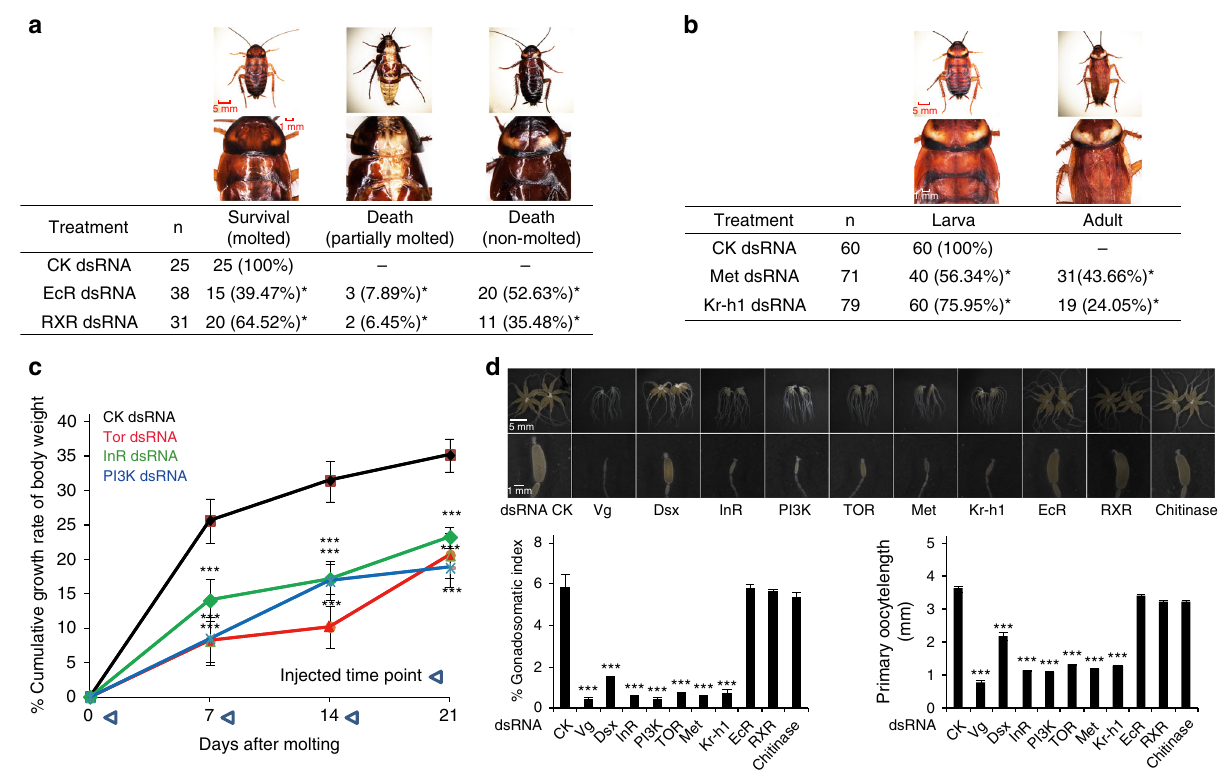
Fig. 4 Functional studies of pathways regulating development and reproduction in the American cockroach. a Regulation of molting by ecdysone receptor ( EcR ) and retinoid X receptor ( RXR ) genes in the 20E signal pathway. Mortality rates were checked after RNAi treatment of indicated numbers of individuals ( n ). CK, control dsRNA corresponds to that in Fig. 3. b Regulation of metamorphosis by methoprene-tolerant ( Met ) and kruppel homolog 1 ( Kr- h1 ) in the juvenile hormone (JH) pathway. Adult proportion index was checked after the JH singling was disrupted. c Regulation of growth by the